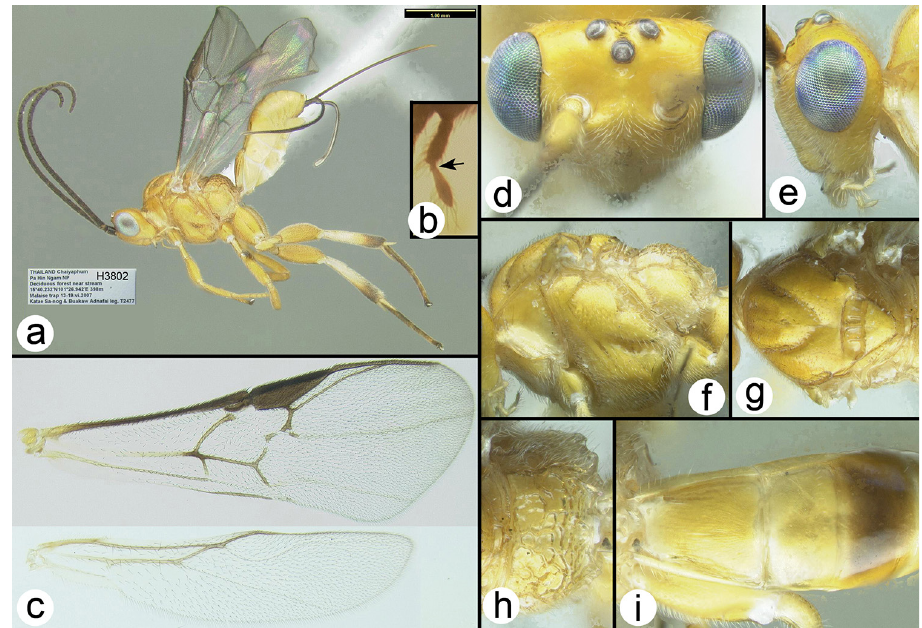
Figure 17. Xanthagathis mellisoma, female: a lateral habitus b labial palp, arrow indicates minute third palpomere c wings d dorsal head e lateral head f lateral mesosoma g dorsal thorax h propodeum i meta- somal terga